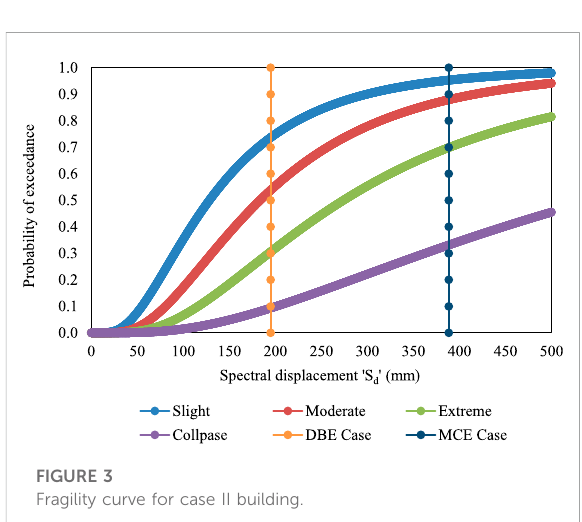
FIGURE 3 Fragility curve for case II building.